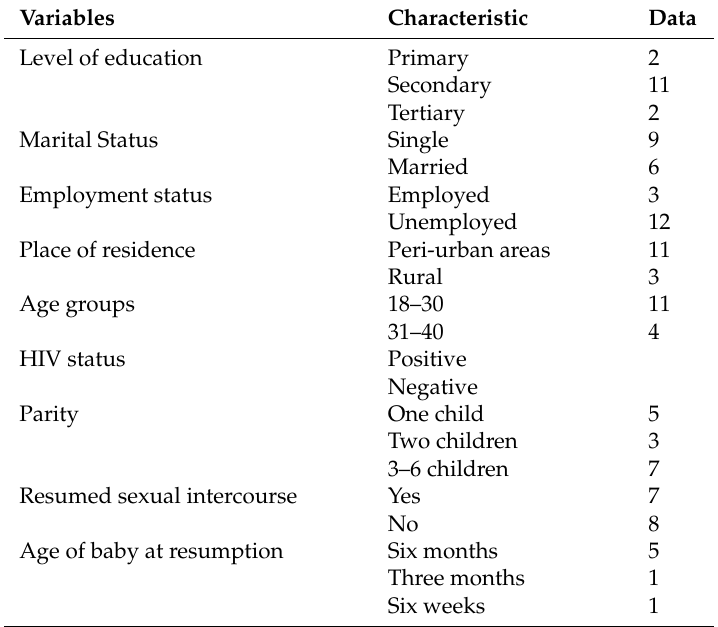
Table 2. Descriptive characteristics of participants.